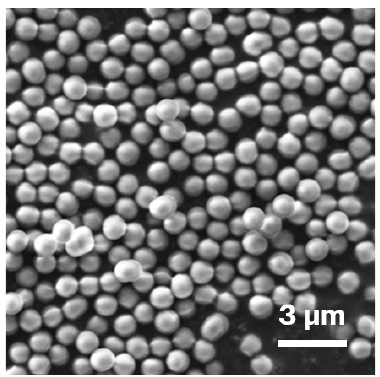
Figure 1. FE-SEM image of ASP.